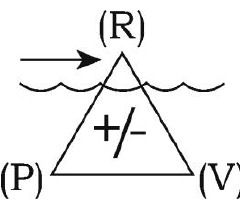
Figure 4b: The Submerged Compassion Triangle - only Victim apparent on Top